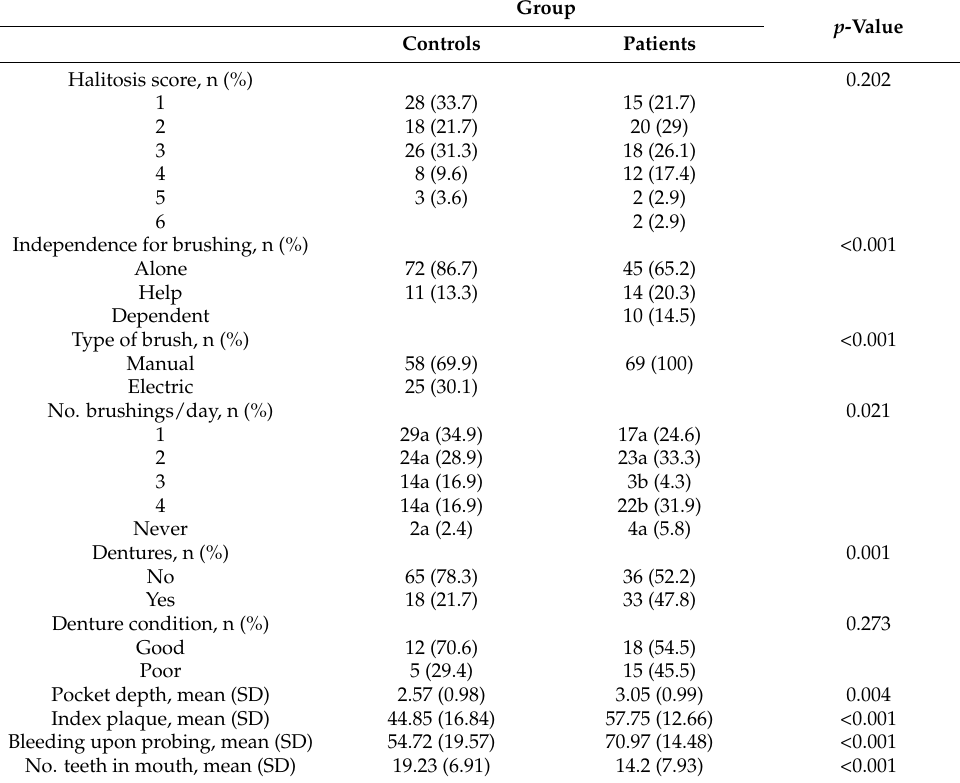
Table 3. Description and comparison of oral health variables of the two study